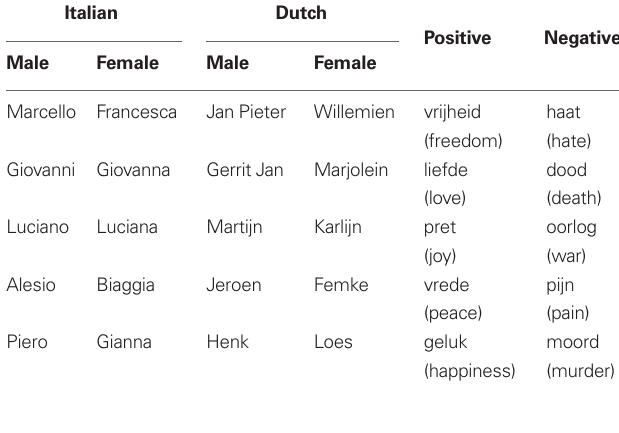
Figure A1 | A screenshot of the iAT task.